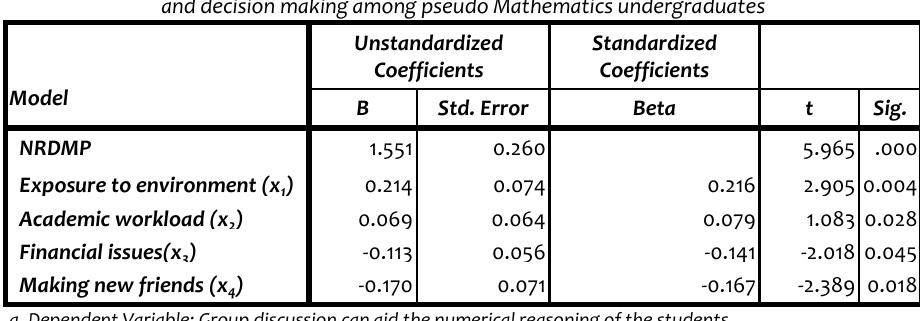
Table 5 : Regression analysis on stress induce variables and numerical